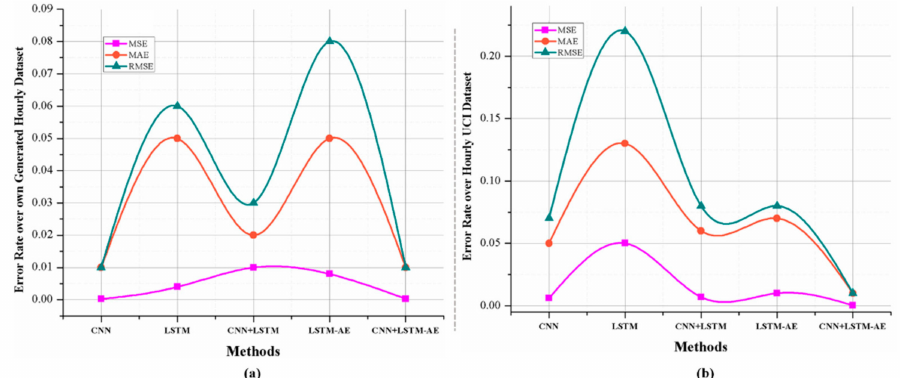
Figure 9. The detailed results of di ff erent deep learning-based models for one day resolution data where ( a ) demonstrates MSE, MAE and RMSE for the Korean commercial building dataset and ( b ) shows these error rates over UCI